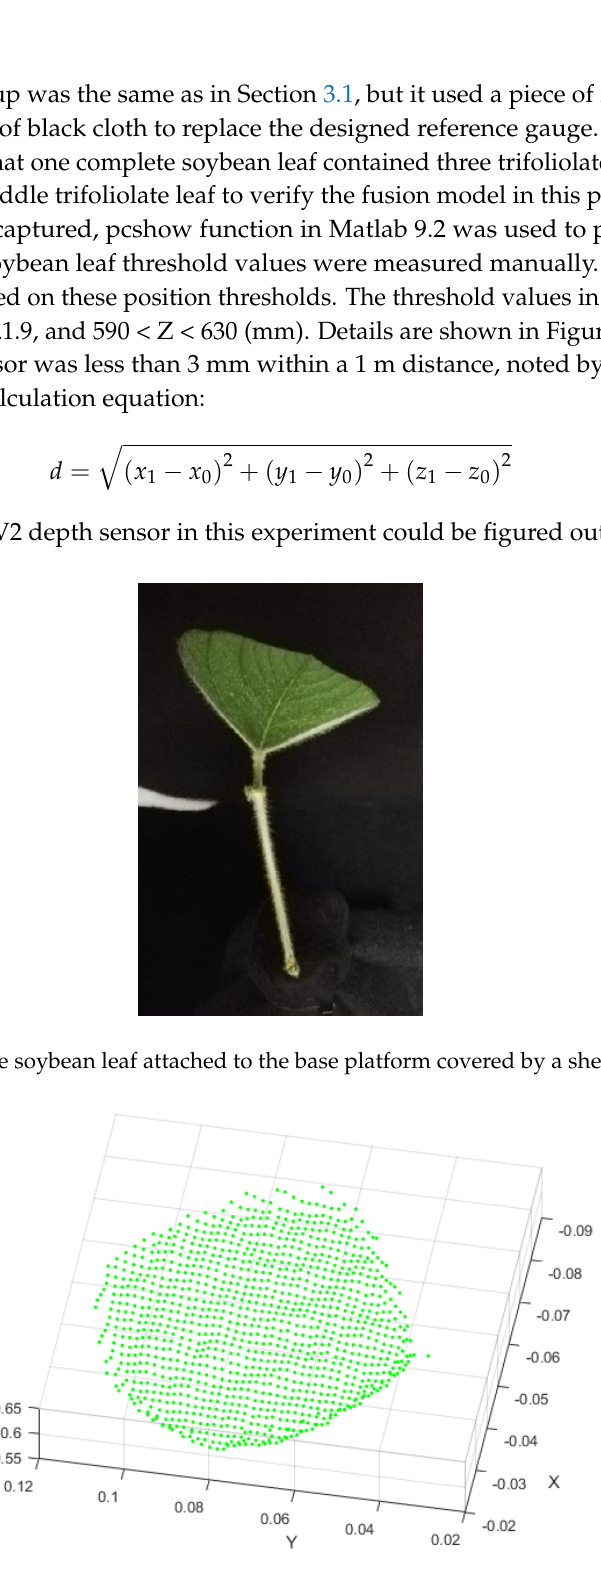
Figure 9. Using the fusion model proposed in this paper to derivate Kinect V2 depth information to hyperspectral image coordinate information. 3.3. Result Summary The imaging system had the ability to reproduce the position of a start point of the system, which was a very important feature as it enabled the direct reuse of the fusion model for multiple images. The proposed method relied on the assumption that all bands of a surface point were projected to the same point in the image [37]. We revised this assumption in the close-range hyperspectral camera used for plant phenotyping. Details of the derivation of the fusion model based on a designed reference gauge, and the verification of the fusion model based on soybean leaf, have been presented in this paper. The movement of the hyperspectral camera was modelled as a simple linear camera model. We achieved satisfying results with pixel scale image coordinate accuracy in fusion model derivation, and 3.3 mm resolution with the low-cost Kinect V2, in close-range soybean indoor experiments with a controlled environment.